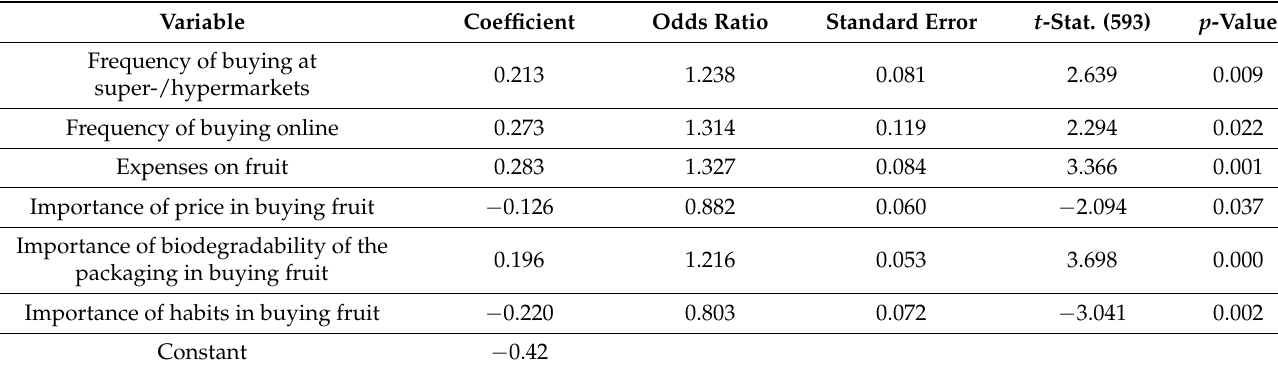
Table 6. Values of logistic regression model